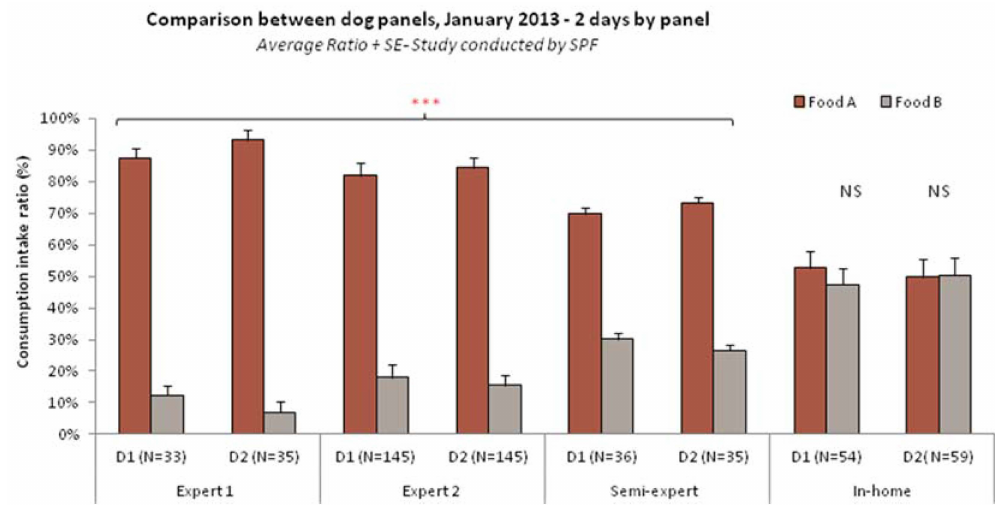
Figure 2. Comparison between dog panels, January 2013, 2 days by panel. Average Ratio + SE, Study conducted by Diana Pet